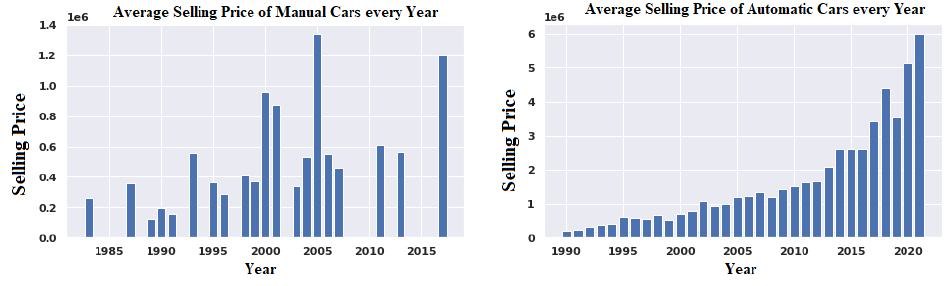
Figure 9. Average selling price of automatic and manual cars of each model_year